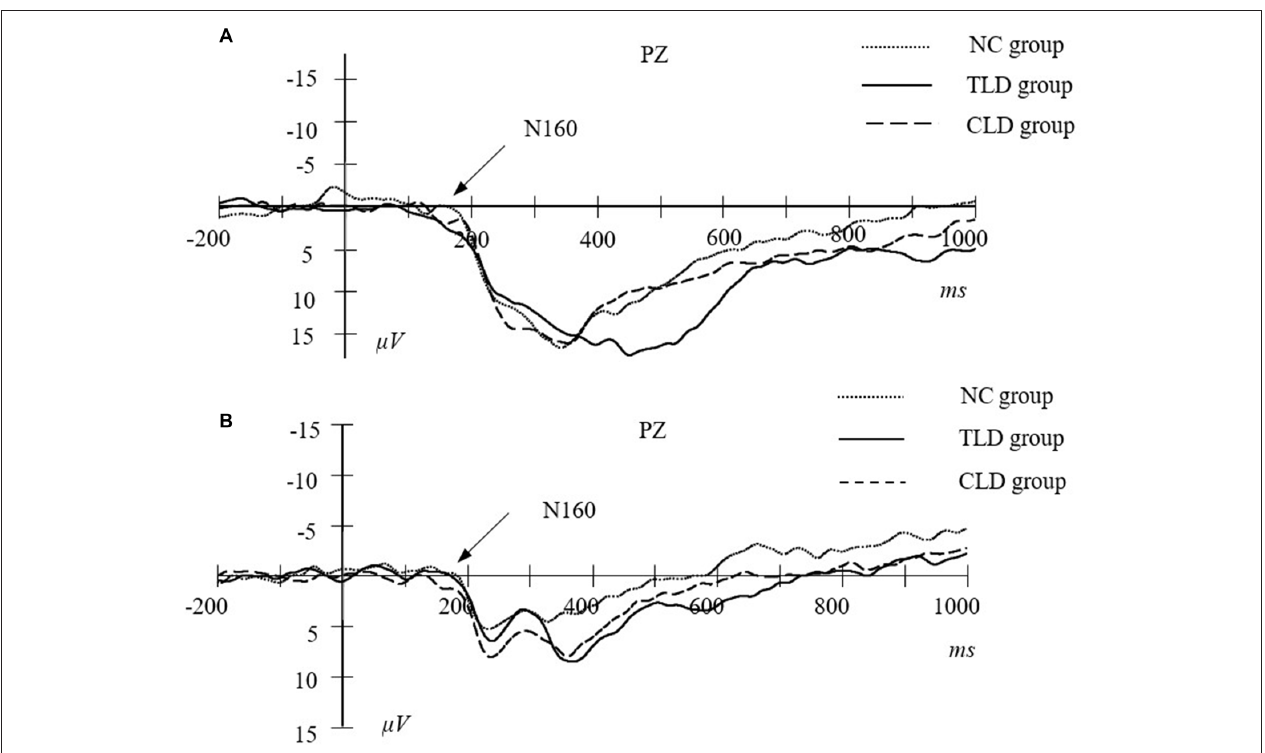
FIGURE 5 | The peak value of N160 in parietal area at pretest (A) and posttest (B) for each